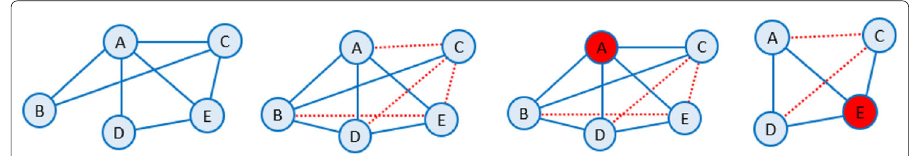
Fig. 7 Evaluating triadic closure prediction in a network (left) in which estimated link ranks (cid:4) M (middle left) assume near-zero values for the dashed links and near-one for the blue links. LinkCC over the neighborhood of nodes A (middle right) and E (right) assumes that immediate neighbors are known and evaluates how many triangles are formed between them compared to the number of triangles in the original